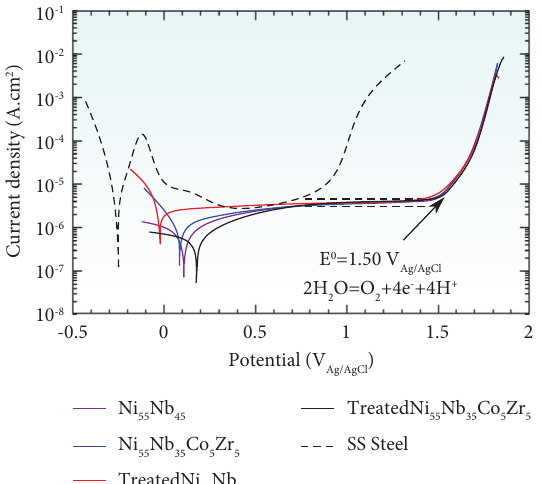
Figure 3: Potentiodynamic polarization curves of raw and treated samples in the condition simulated for proton exchange membrane fuel